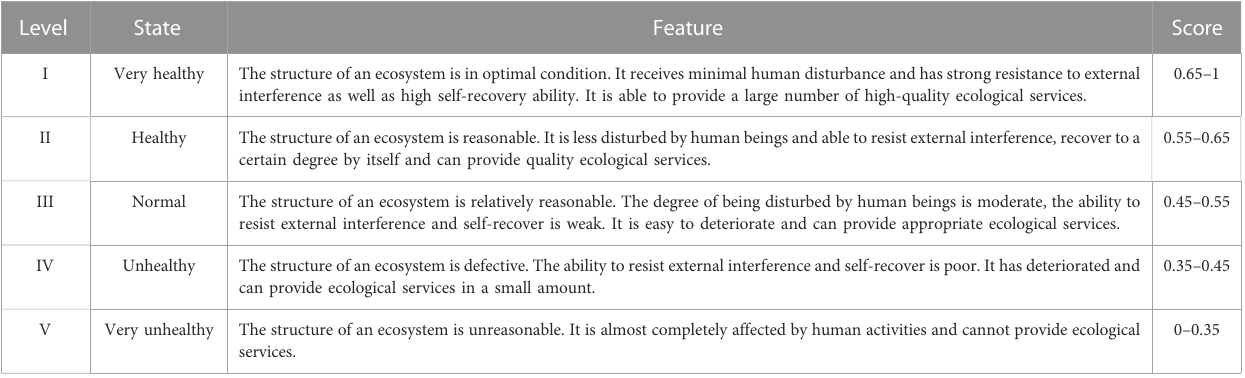
TABLE 1 Ecosystem health grading